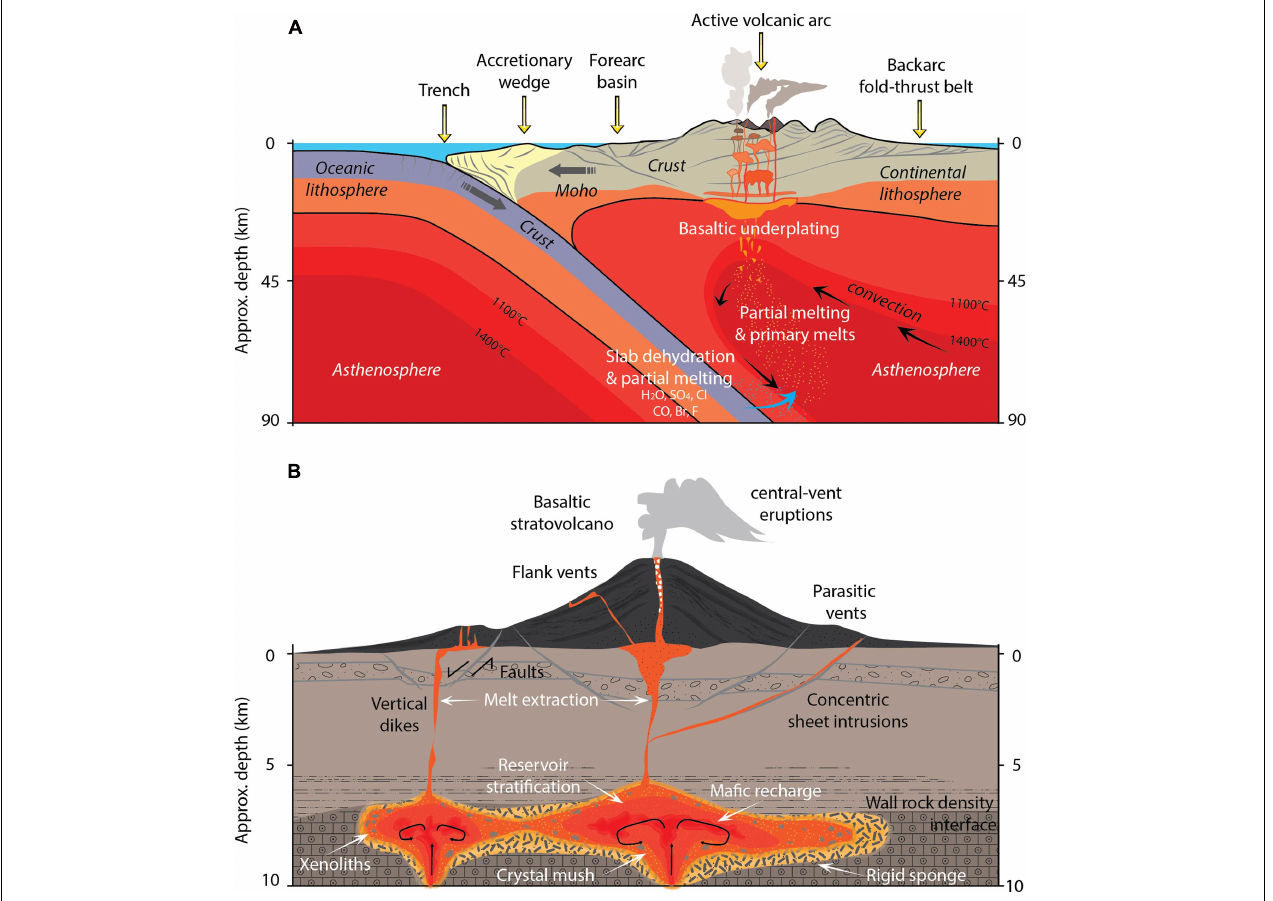
FIGURE 2 | Basaltic volcanism in arc settings. (A) Cartoon (not to scale) of the oceanic-continental lithosphere subduction showing the main processes of slab dehydration and generation of partial melts which accumulate below the crust (underplating), then feeding the active volcanism of the overlying arc. Illustration based in Schmidt and Poli (1998). (B) Cartoon (not to scale) of the shallow storage and plumbing system of a basaltic